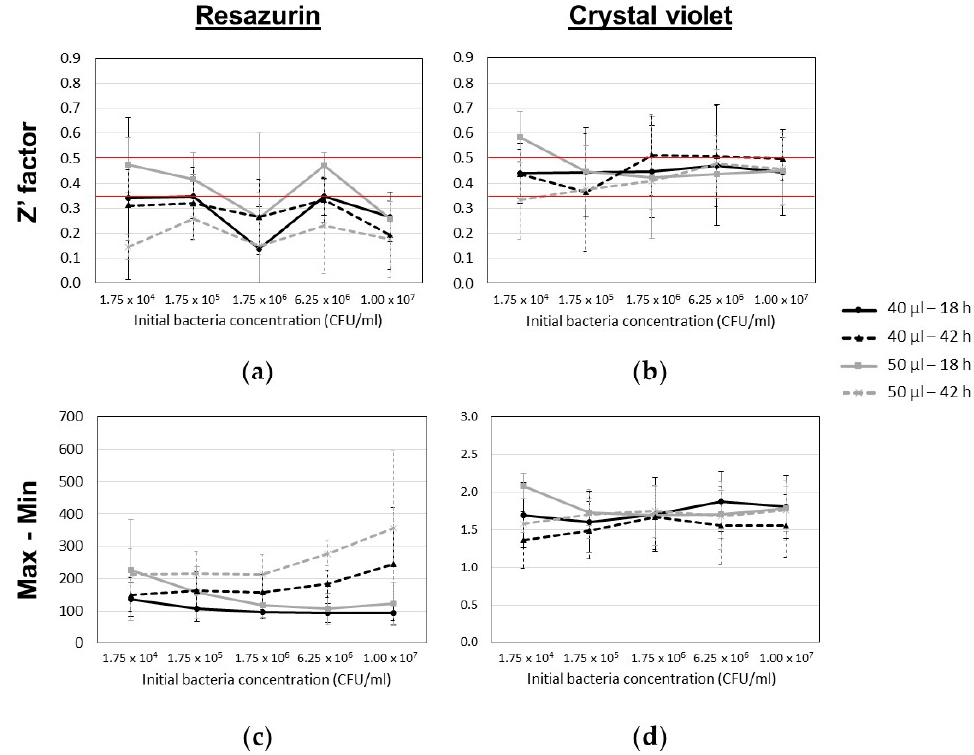
Figure 2. The effect of different initial P. aeruginosa concentrations and working volumes on the performance of a miniaturized biofilm screening assay in 384WP. Assay performance is measured using the Z’ factor ( a , b ) and the maximum minus minimum signal ( c , d ) of the resazurin and crystal violet staining of P. aeruginosa biofilms grown for 18 h or 42 h in a volume of 40 µL or 50 µL with different initial bacterial concentration in 384WP. Maximum minus minimum results are expressed in RFUs for resazurin or RAUs for crystal violet. Results are based on 3–4 independent biological replica experiments, each plate containing 28–40 technical replicates for each condition and 30 media control replicates. The red lines in panels a and b represent the thresholds for the determination of the quality of the assay: acceptable (Z = 0.35) and good (Z = 0.5).